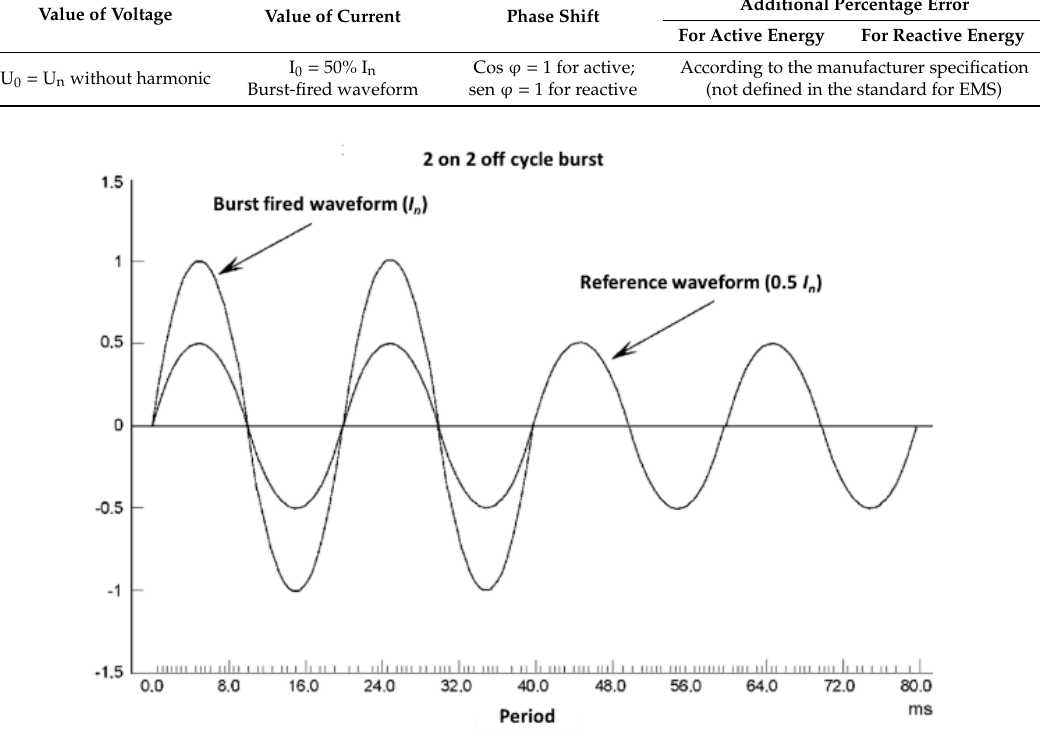
Figure 13. Burst-fired current waveform.